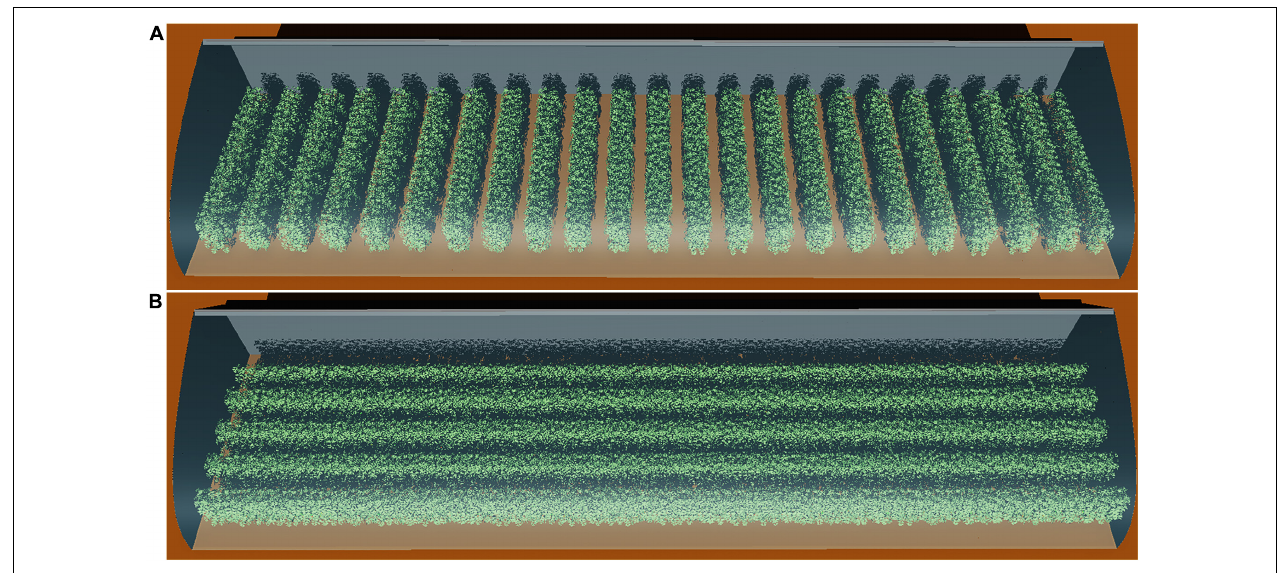
FIGURE 1 | Snapshot of the 3D model of a 30 m long Liaoshen-solar greenhouse (LSG) including the tomato canopy with N–S row orientation (A) and E–W row orientation (B) . While a typical LSG is about 60 m, a 30-m version was used for simulation to reduce computation time and so enables us to simulate more scenarios. A reduction in dimensions at this low rate still allows simulations without any impact on the overall simulated results.